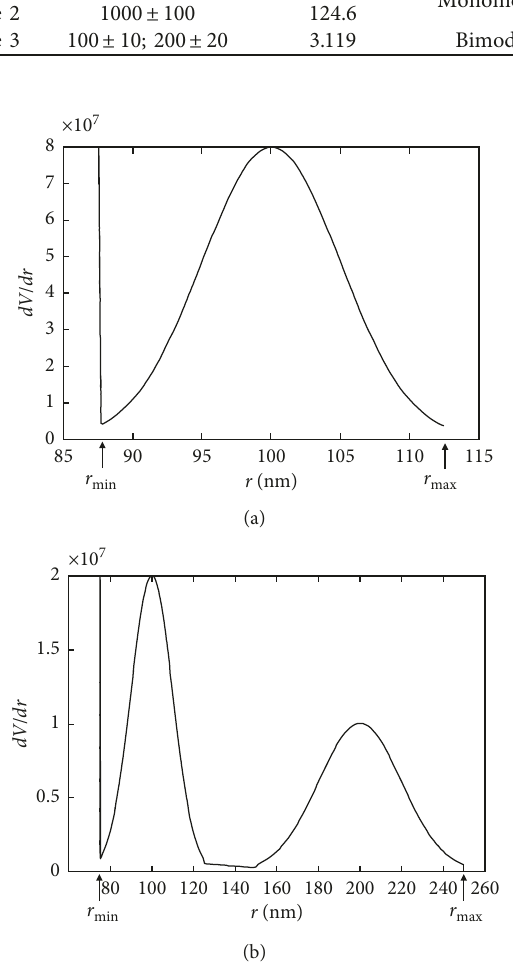
Figure 12: Monomodal pore-size distribution ((a) 100 ± 5nm) and bimodal pore-size distribution ((b) 100 ± 10nm and 200 ± 20